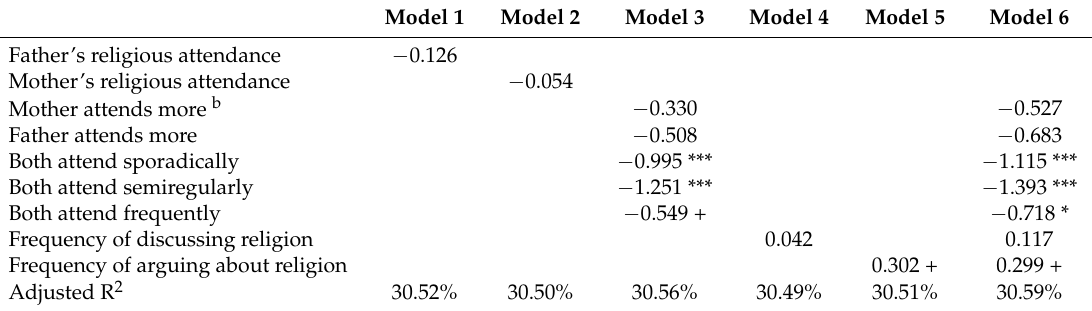
Table 9. Unstandardized coefficients predicting children’s standardized science test scores (n = 10,720) a